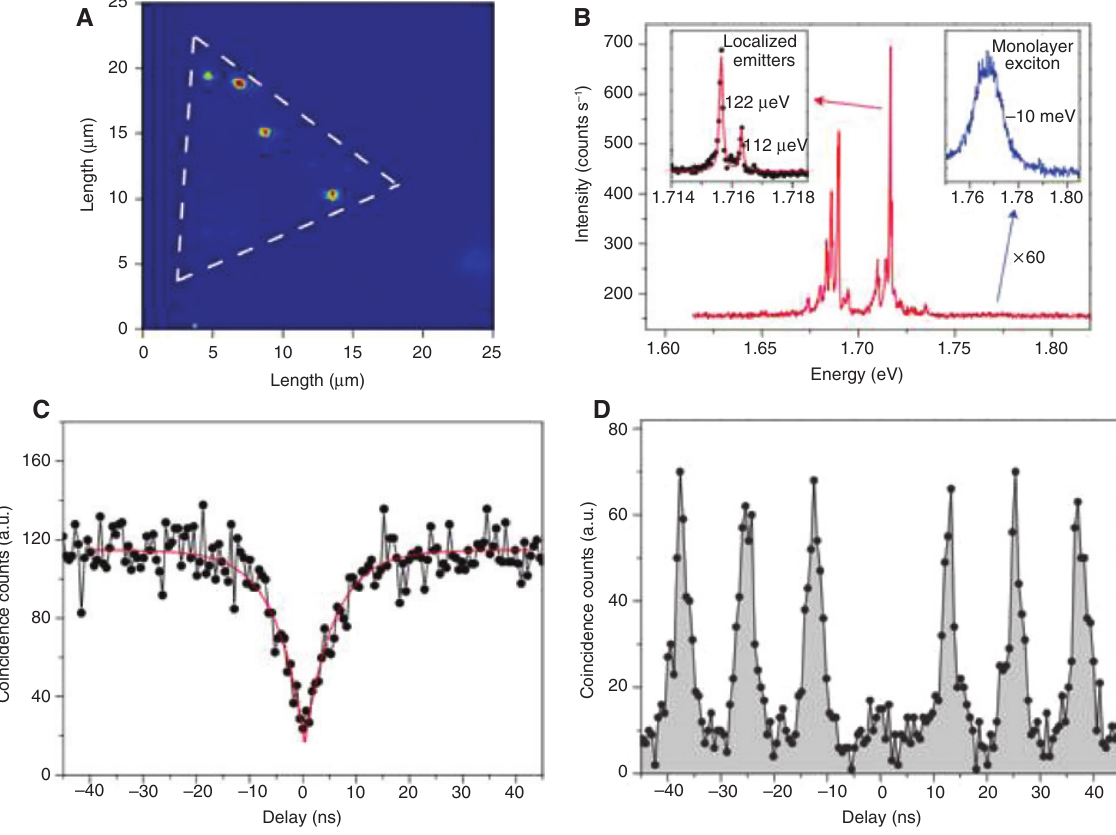
Figure 9: Single quantum emitters in layered materials. (A) Photoluminescence intensity map of narrow emission lines over 25 μ m × 25 μ m area. The dashed triangle indicates the position of the monolayer; (B) photoluminescence spectrum of localized emitters. The left inset is a high-resolution spectrum of a defect emission. The right inset is a zoom-in of the monolayer valley exciton emission; observation of photon anti-bunching with (C) CW and (D) pulsed excitation. The dip at zero time-delay indicates presence of single photons. This figure is reprinted from Ref. [111].